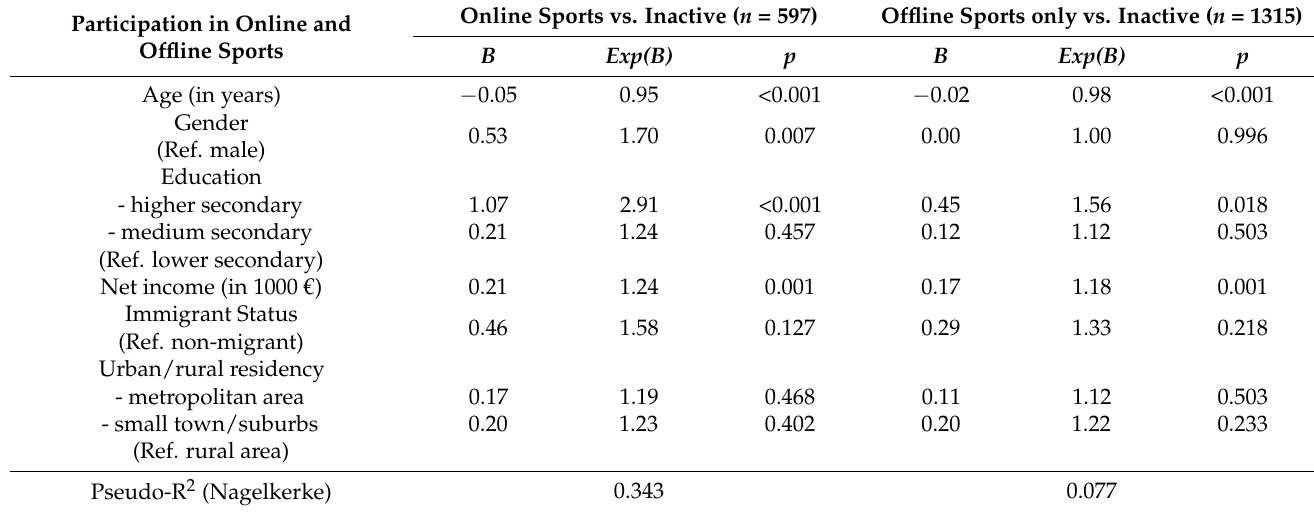
Table 2. Logistic regression models for participation in online/offline sports vs. inactivity. Participation in Online